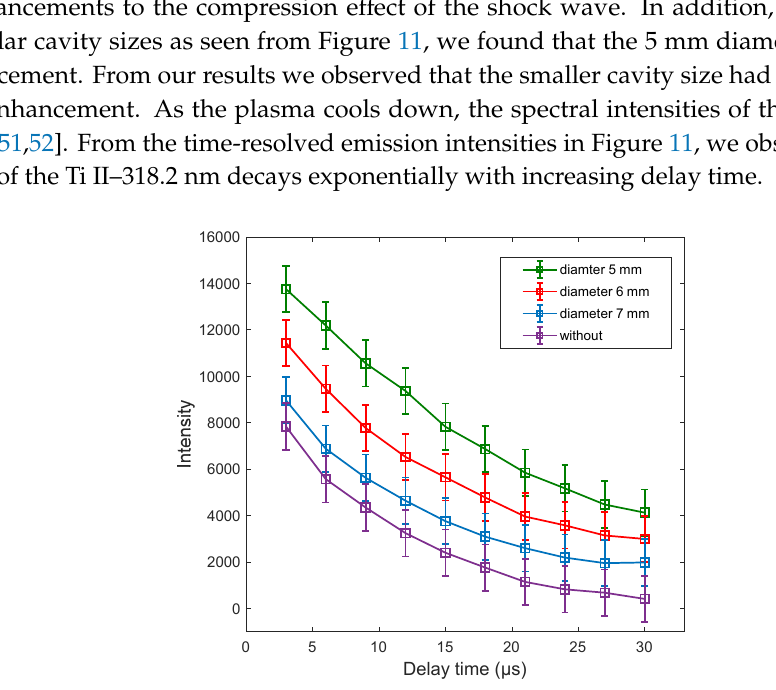
Figure 11. Time-resolved emission intensities of the Ti II–318.2 nm spectral lines for different sizes of the circular cavity at laser fluence of 18.1 J cm − 2 .